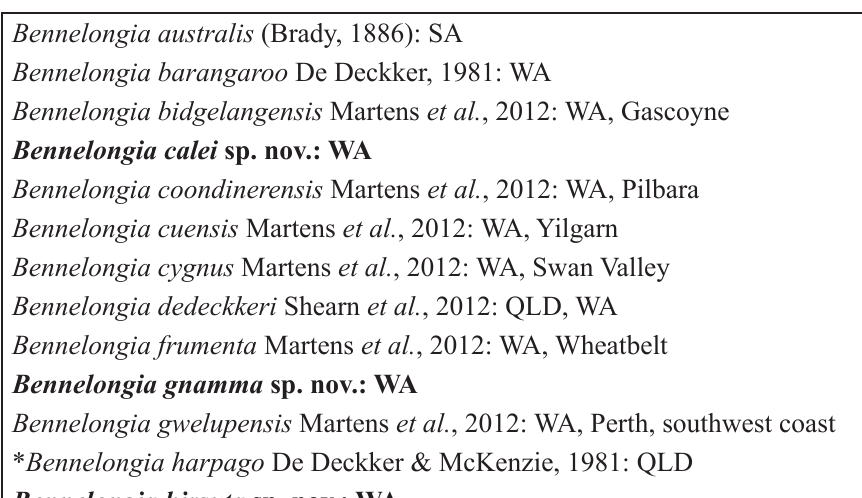
Table 3. species presently described in Bennelongia and their distribution (species in bold are newly described here). Only certain distributions, based on type localities and documented range extensions, are given here. * indicates the type